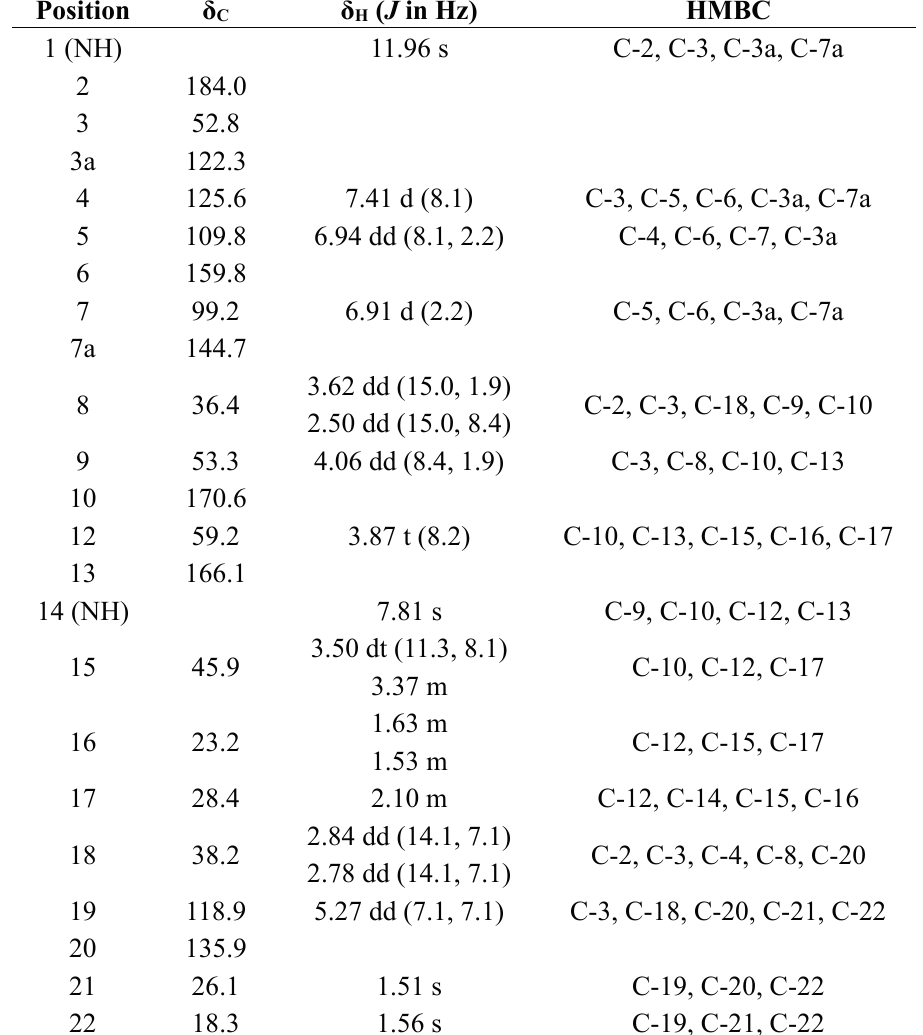
Table 1. 1 H-NMR and 13 C-NMR data of 1 (800 MHz for 1 H, 200 MHz for 13 C in pyridine- d 5